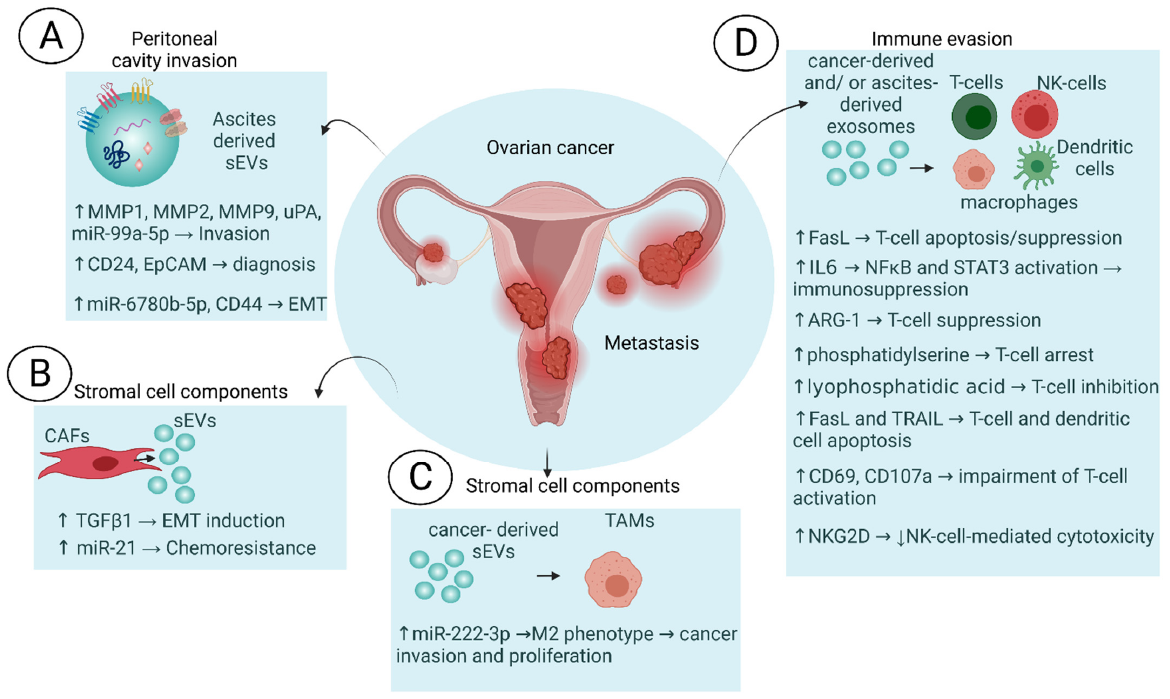
Figure 1. The complex ovarian cancer microenvironment and the role of EVs. EVs may be involved in multiple processes that regulate the tumor microenvironment. Metastasis is promoted through the delivery of EVs to target cells; EVs released from cancer-associated fibroblasts can lead to reprogramming of the ECM as well as chemoresistance; EVs released from cancer cells may be carrying immunosuppressive cytokines. ( A ) Peritoneal cavity invasion [41–48]; ( B ) Cancer-associated fibroblasts [49,53]; ( C ) Tumor-associated macrophages (TAMs) [55]; ( D ) Immune evasion [56–60,63–65]. Created with Bio- Render.com.